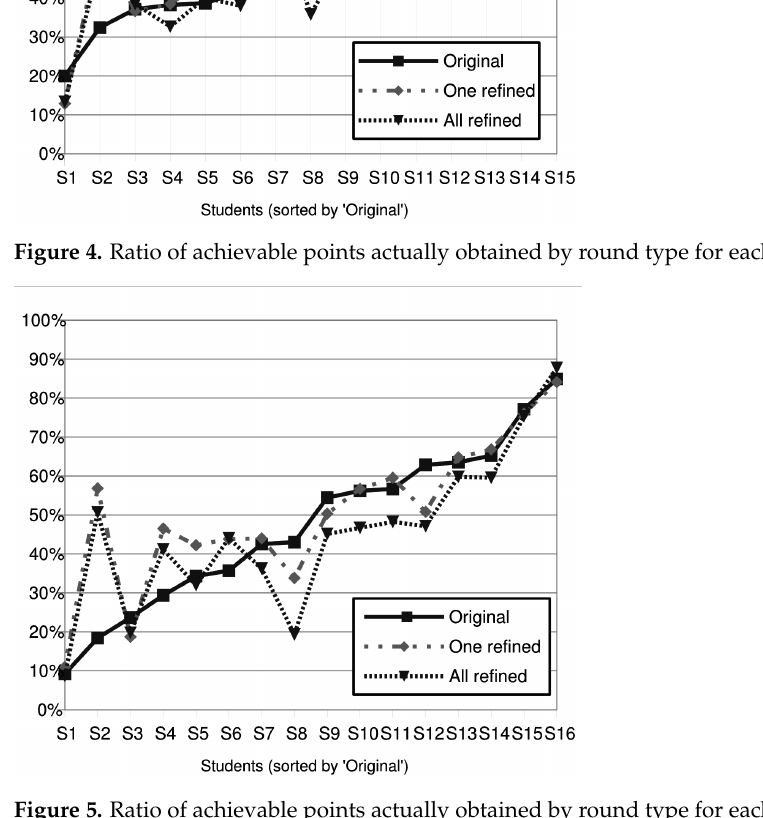
Figure 5. Ratio of achievable points actually obtained by round type for each student in cohort 2.